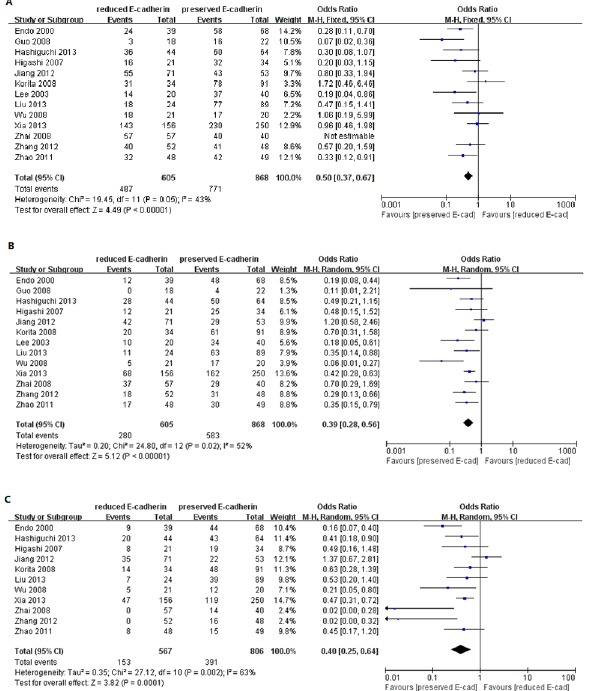
Figure 3. Forest plot displaying the results of the meta-analysis on 1-year (A), 3-year (B) and 5-year (C) recurrence-free